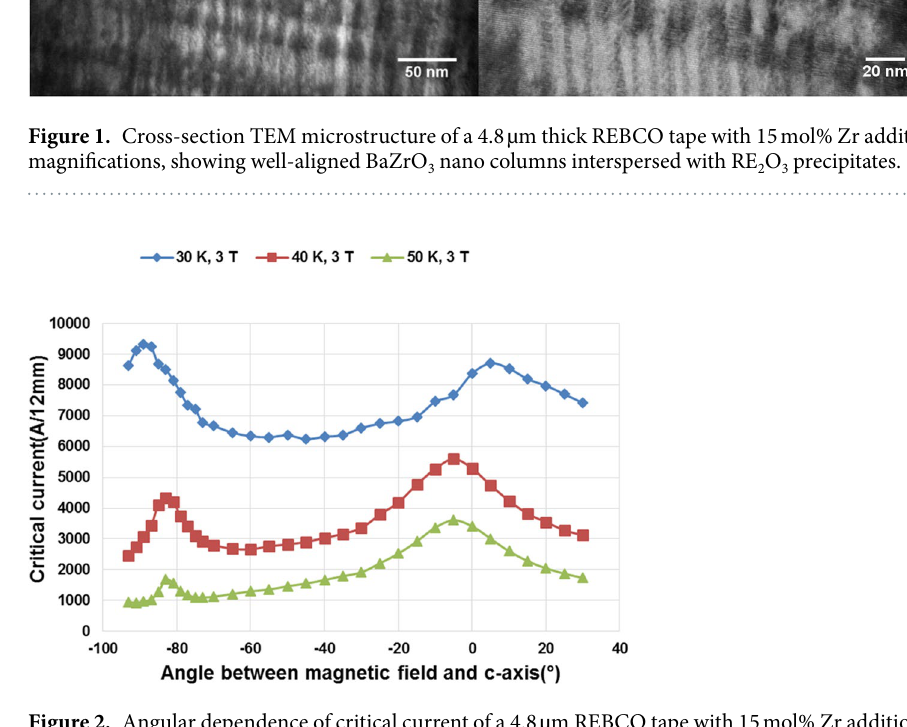
Figure 2. Angular dependence of critical current of a 4.8 µ m REBCO tape with 15 mol% Zr addition at 30 K, 40 K and 50 K in 3T magnetic